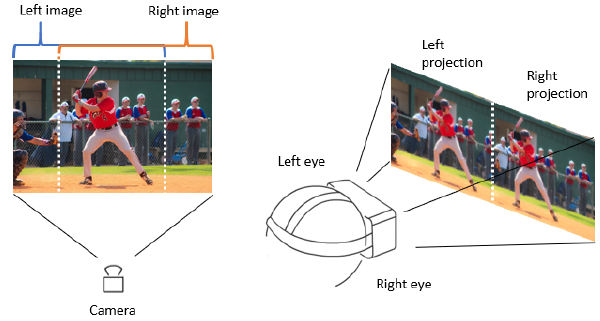
Figure 19. Treatment of the camera image.